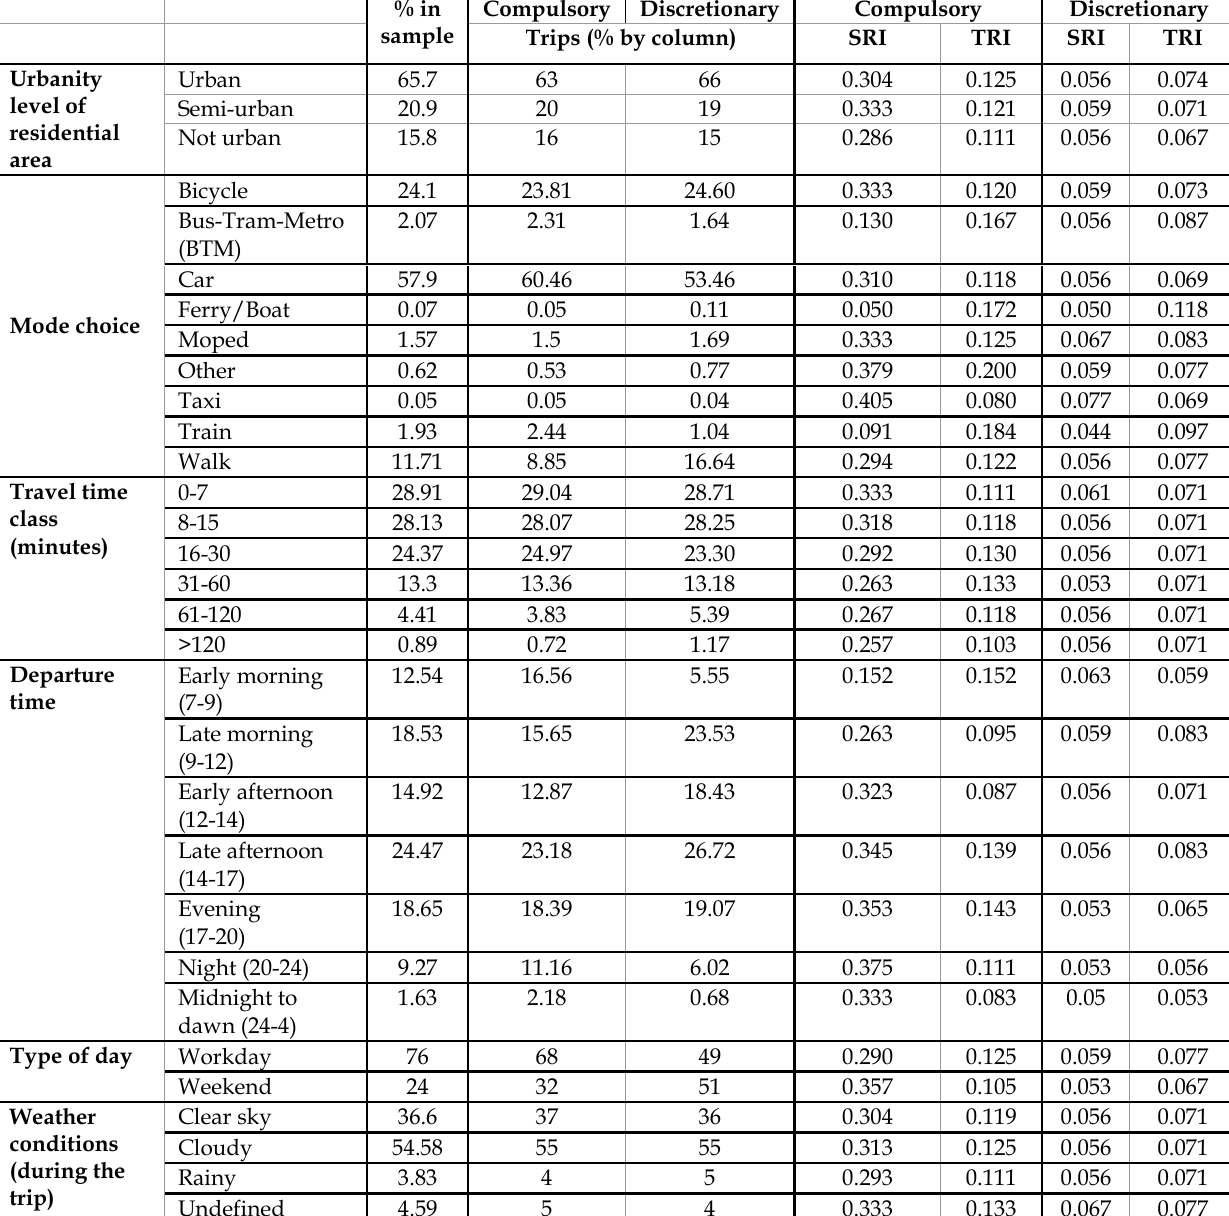
Table 2. cont.,-Descriptive statistics of socio-economic variables (SRI, TRI, median) % in Compulsory Discretionary sample